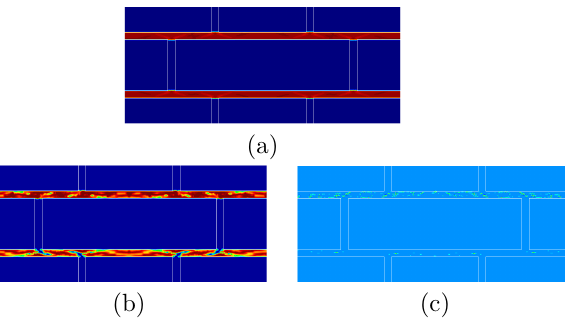
Figure 11. Damage pattern due to E yy > 0